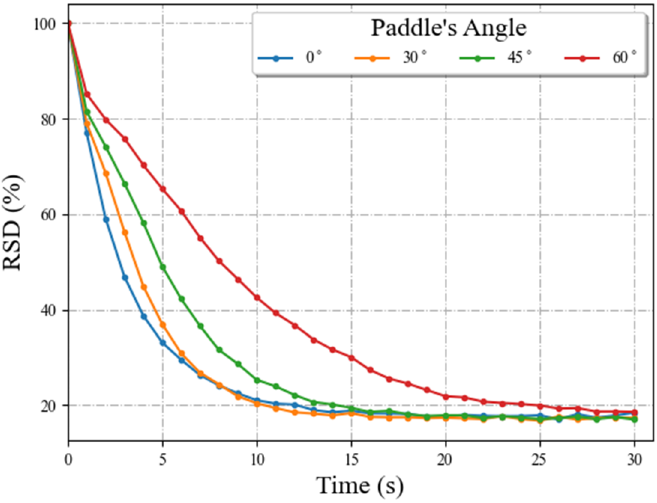
Figure 7. RSD values versus time for various paddle angles.